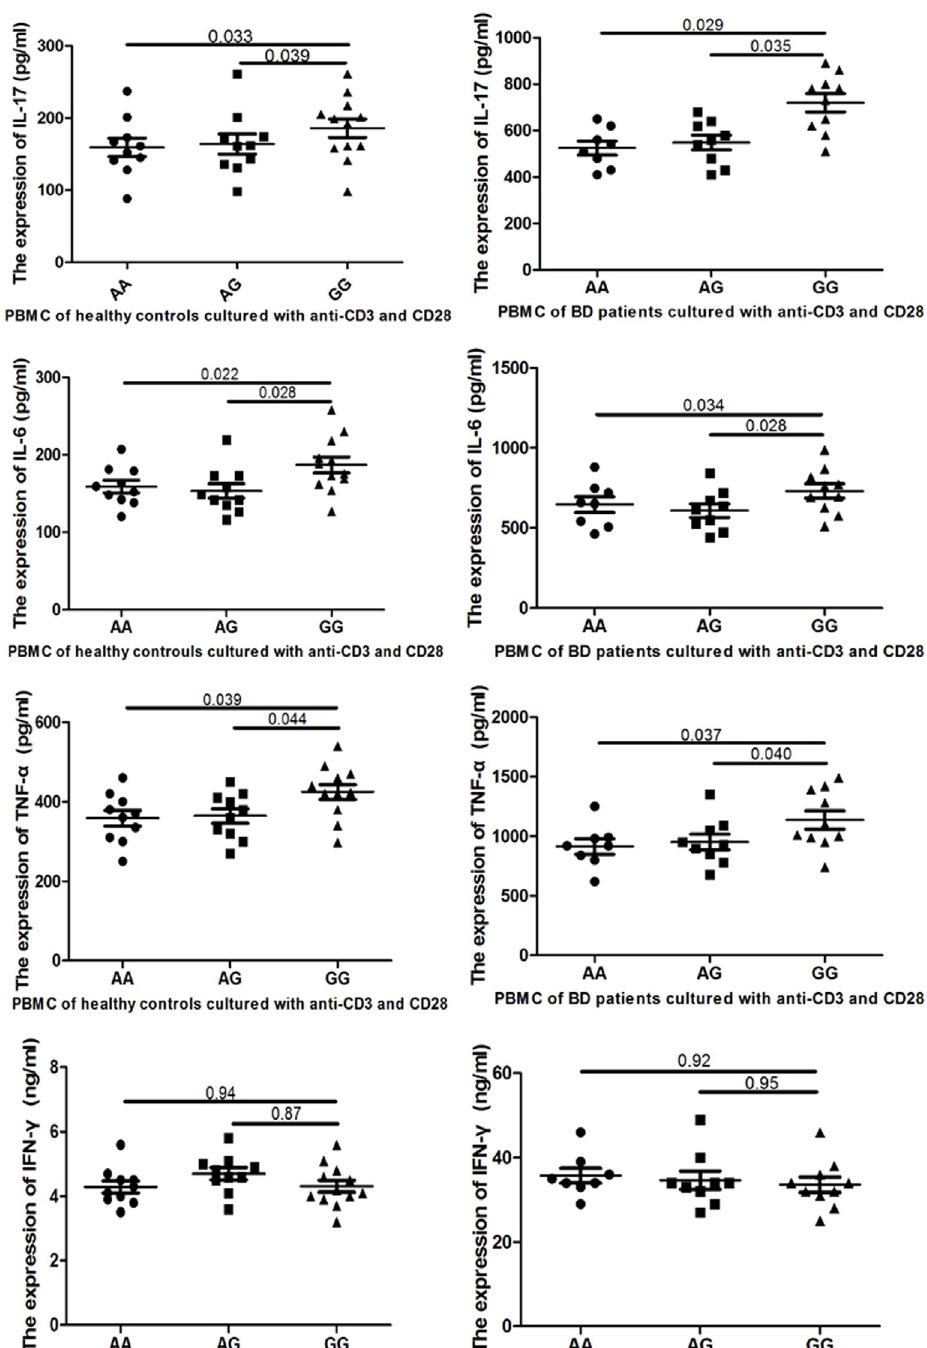
Fig 2. The IL-17, IFN- γ , TNF- α and IL-6 expression levels of peripheral blood mononuclear cells (PBMC) obtained from healthy individuals and patients with Behcet ’ s disease with the rs17375018 AA, AG and GG